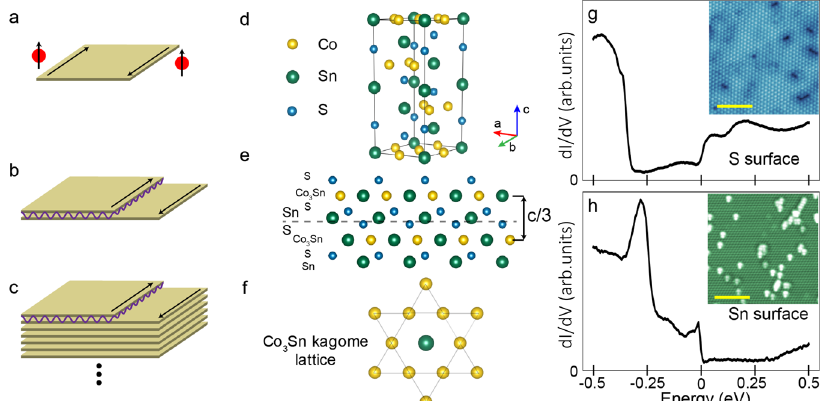
Fig. 1 Crystal structure, topography, and spectroscopy of Co 3 Sn 2 S 2 . a Single Chern insulator, with one chiral edge state. b Chern insulator bilayer system with step geometry and inter-layer coupling (represented by the purple lines).When the coupling is strong enough to turn the bilayer system trivial, chiral edge states appear at the edges of the exposed planes as well as at the interface of the bilayer and single layer. c Large stack of Chern insulators with intermediate inter-layer coupling to form a Weyl semimetal. For large regions of parameter space, the Weyl semimetal phase coincides with the conditions necessary for the counter-propagating chiral edge states seen in b (see Supplementary Note 1). d Unit cell of Co 3 Sn 2 S 2 . Sn is represented by a large green sphere, Co by a medium yellow sphere, and S by a small blue sphere. e Several layers of the crystal as viewed from the (100) plane. Cleavage occurs between the Sn and S layers, as indicated by a dashed line. f Schematic of the kagome structure present in the Co 3 Sn plane with Co forming 6 triangles surrounding a central Sn atom. g Spectra typical of S surface ( I = 300 pA, V = 500 mV). Inset is 30 nm × 30 nm topography showing vacancies typical of S surface ( I = 30 pA, V = 500 mV). The scale bar in the inset is 10 nm. h Spectra typical of Sn surface ( I = 60 pA, V = 500 mV). Inset is 30 nm × 30 nm topography showing adatoms typical of Sn surface. ( I = 110 pA, V = 80 mV). The scale bar in the inset is 10